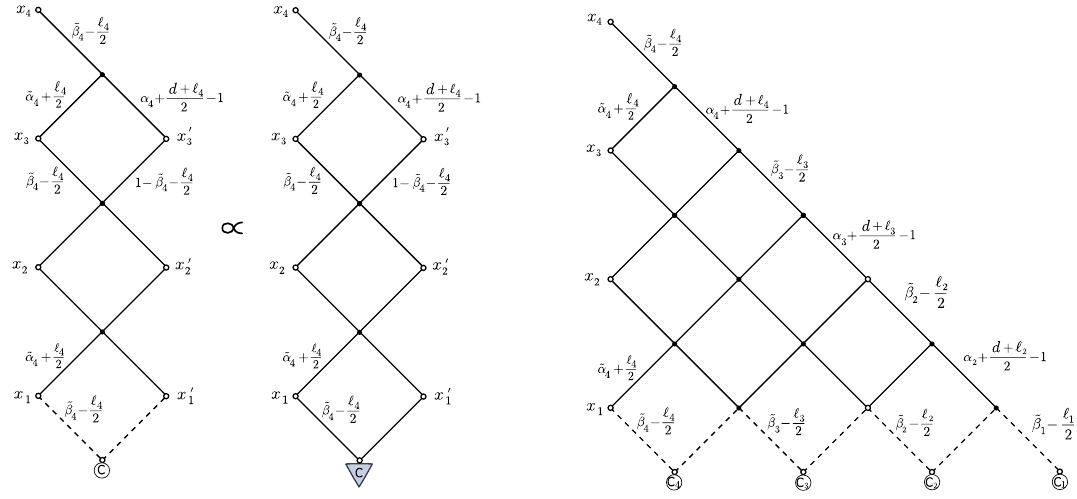
) · Λ 4 ( u 4 ) . The 0 ) . Right: graphical representation of the 0